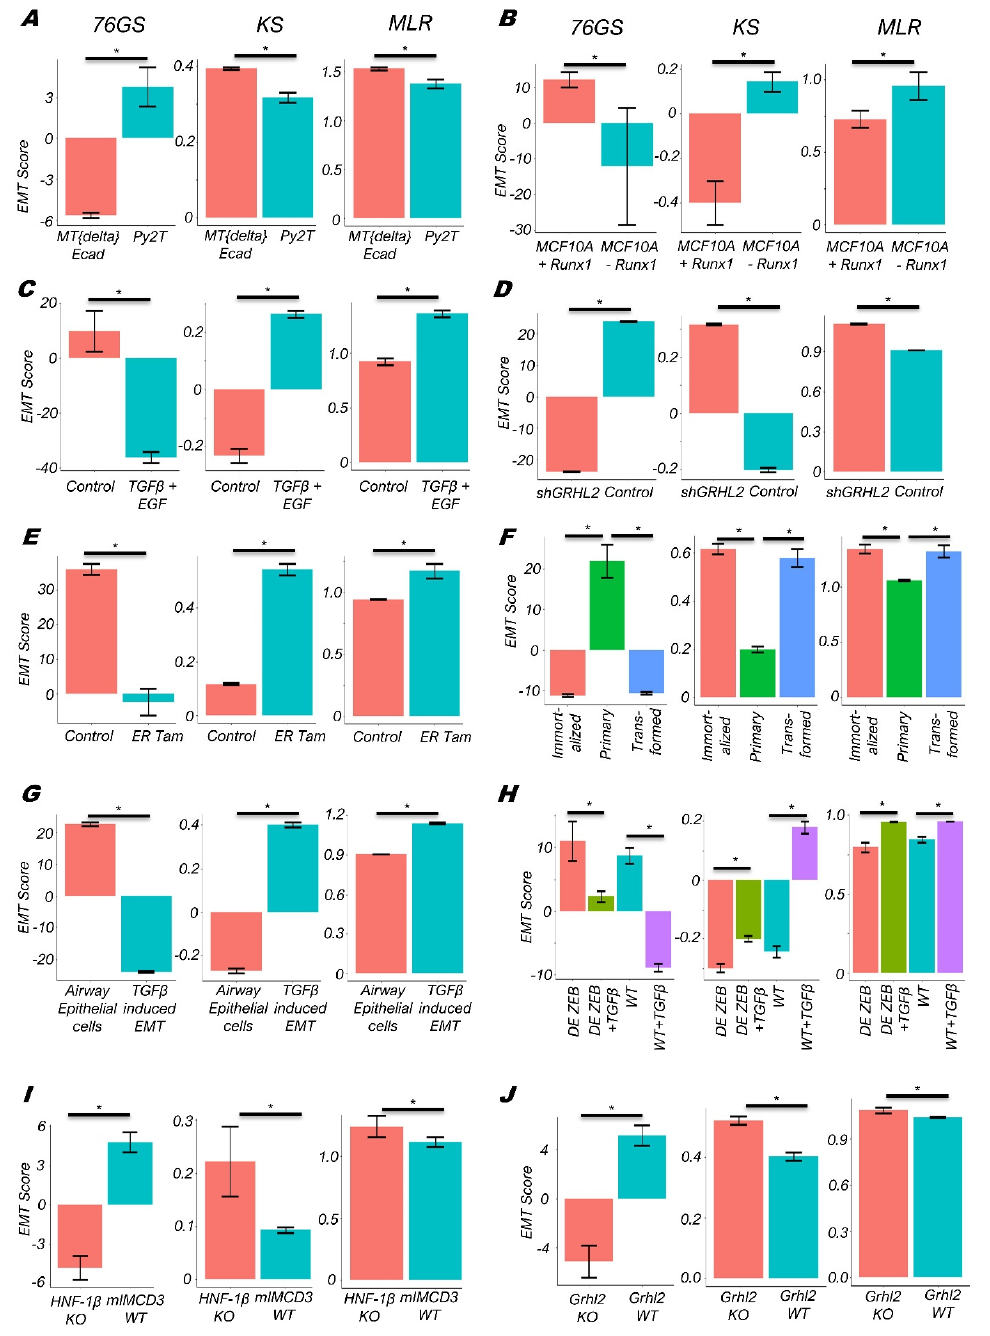
Figure 2. KS, 76GS, and MLR scores for different EMT associated datasets. ( A ) Py2T long term cells and mesenchymal breast cancer cells (MT ∆ ECad) treated with different inhibitors (GSE118612). ( B ) MCF10A cells with or without depletion of Runx1 (GSE85857). ( C ) EMT induction in Hela cells by TGF- β + EGF (GSE72419) treatment. ( D ) EMT induction in small airway epithelial cells by TGF- β (GSE61220). ( E ) MCF10A cells with/without ZEB1 knocked out (KO) untreated or treated with TGF- β (GSE124843). ( F ) OVCA4209 cells with/without GRHL2 knockdown (GSE118407). ( G ) Grhl2 KO and wild type (WT) mice (GSE106130). ( H ) Primary, pre-malignant immortalized, and Ras- transformed human mammary epithelial cells (GSE110677). ( I ) EMT induction in HMLE/Twist-ER cells by tamoxifen (GSE139074). ( J ) EMT status in HNF-1 β -deficient mIMCD3 cell lines (GSE97770). *: p <0.05 for Students’ t